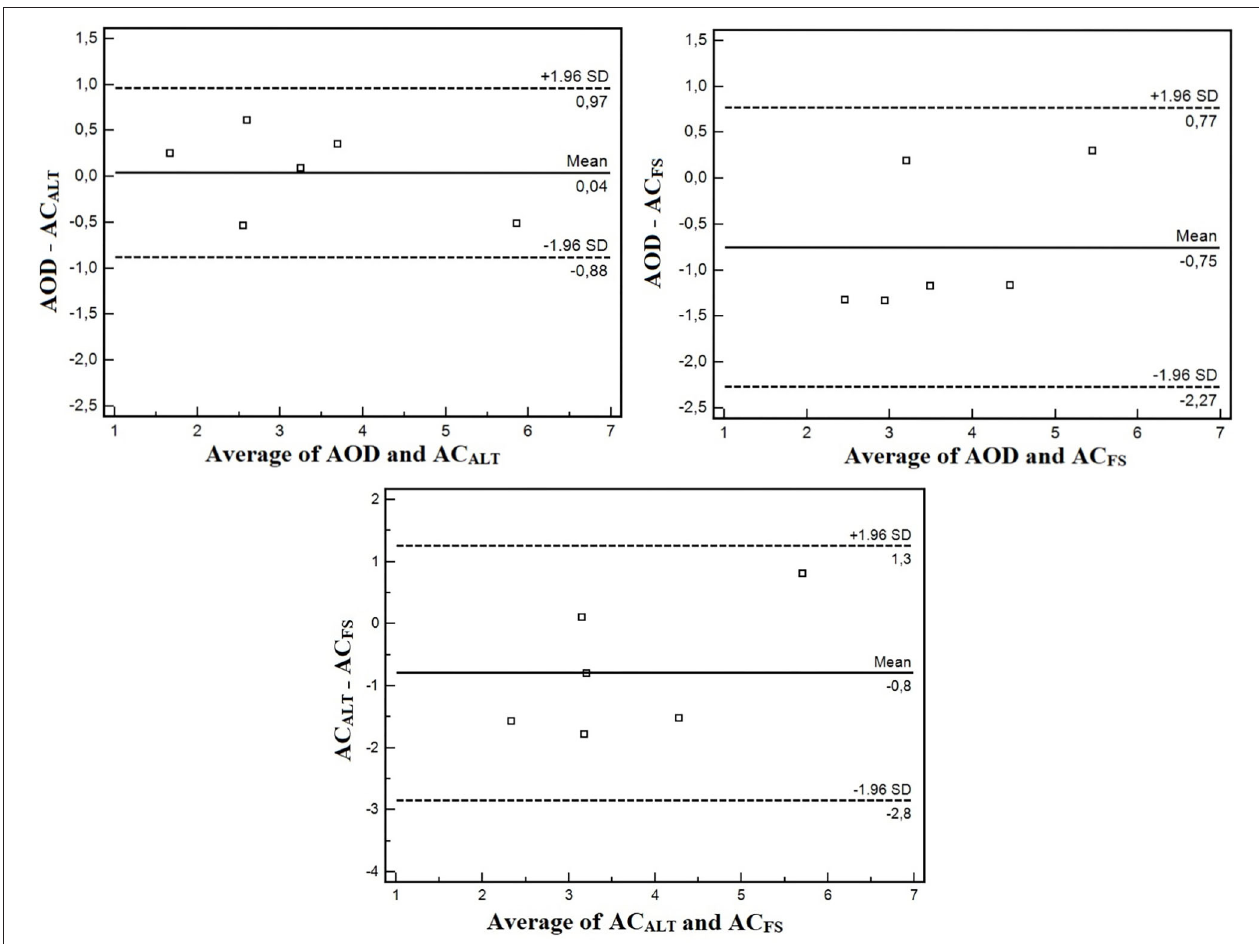
FIGURE 6 | Bland and Altman agreement analysis between AOD and AC ALT , AOD and AC FS , and AC ALT , and AC FS